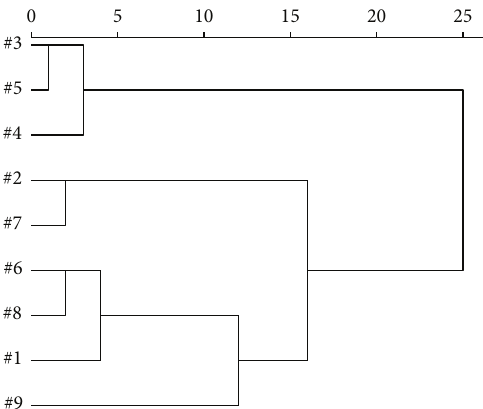
Figure 7: The cluster analysis result of nine Zuotai samples. Note: #1 is the sample of Aba Prefecture Tibetan Medicine Hospital; #2 is the sample of Gan’na Prefecture Tibetan Medicine Hospital; #3, #4, and #5 are the samples of the Company of Tibetan Medicine of Tibetan Traditional Medical College; #6, #7, and #8 are the samples of Qinghai Province Tibetan Medicine Hospital; #9 is the sample of the Company of Tibetan Medicine of Tibetan Autonomous Region.